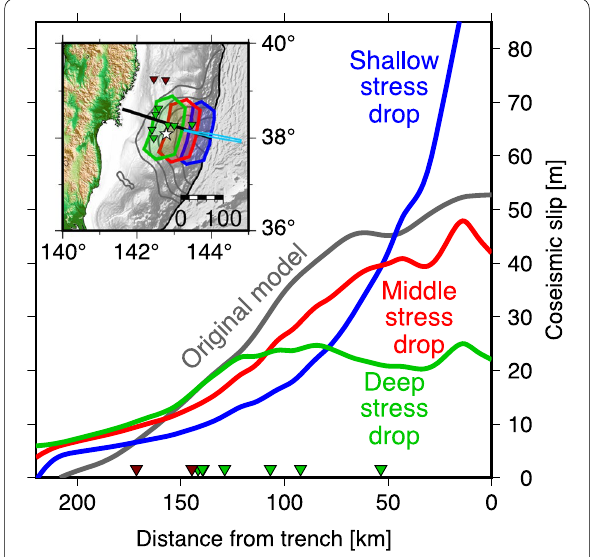
Fig. 11 Cross-sectional view of fault slip for the numerical evaluation test. The slip distribution profiles assuming coupling at the shallowest (blue), middle (red), and deeper (green) portions of the plate boundary, respectively, are shown. The colors, shading, triangles, and bathymetry description are the same as in the legend of Fig.